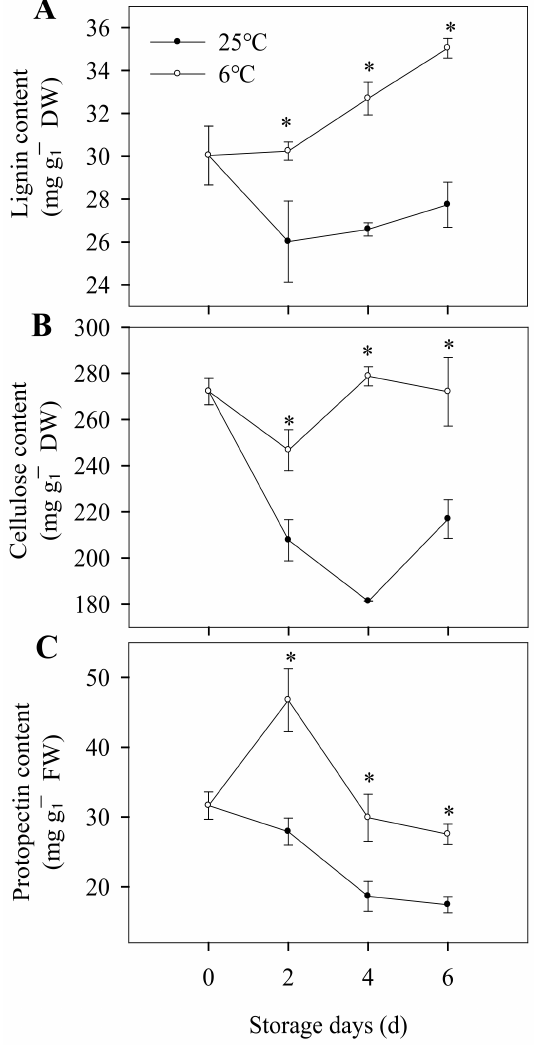
Figure 4. Changes in cell wall component of banana fruit during storage at 6 ◦ C and 25 ◦ C. Lignin content ( A ), cellulose content ( B ), and protopectin content ( C ) of banana peels during storage. Each data point represents a mean ± standard error ( n = 3). ‘*’ means a significant difference between control and experimental fruit at 5%